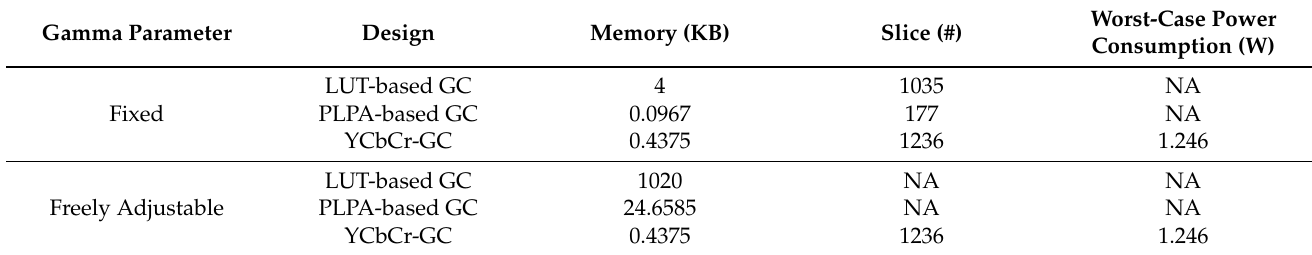
Table 3. Comparative evaluation with two conventional approaches. NA stands for not available. The symbol # denotes quantities. Gamma Parameter Design Memory (KB) Slice